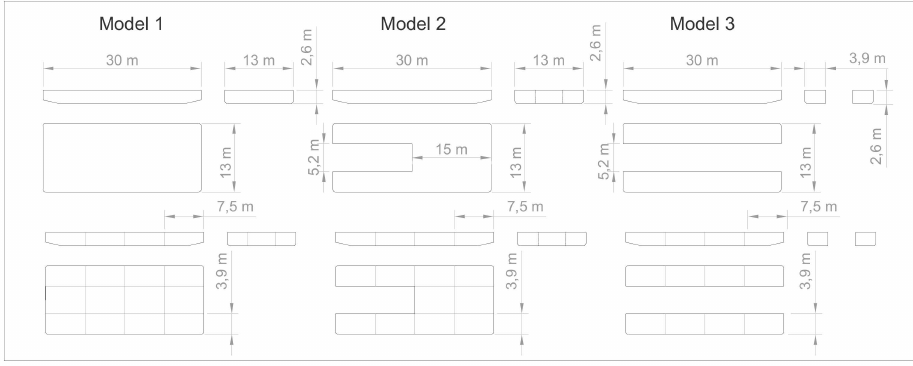
Figure 3. Models of dredgers.